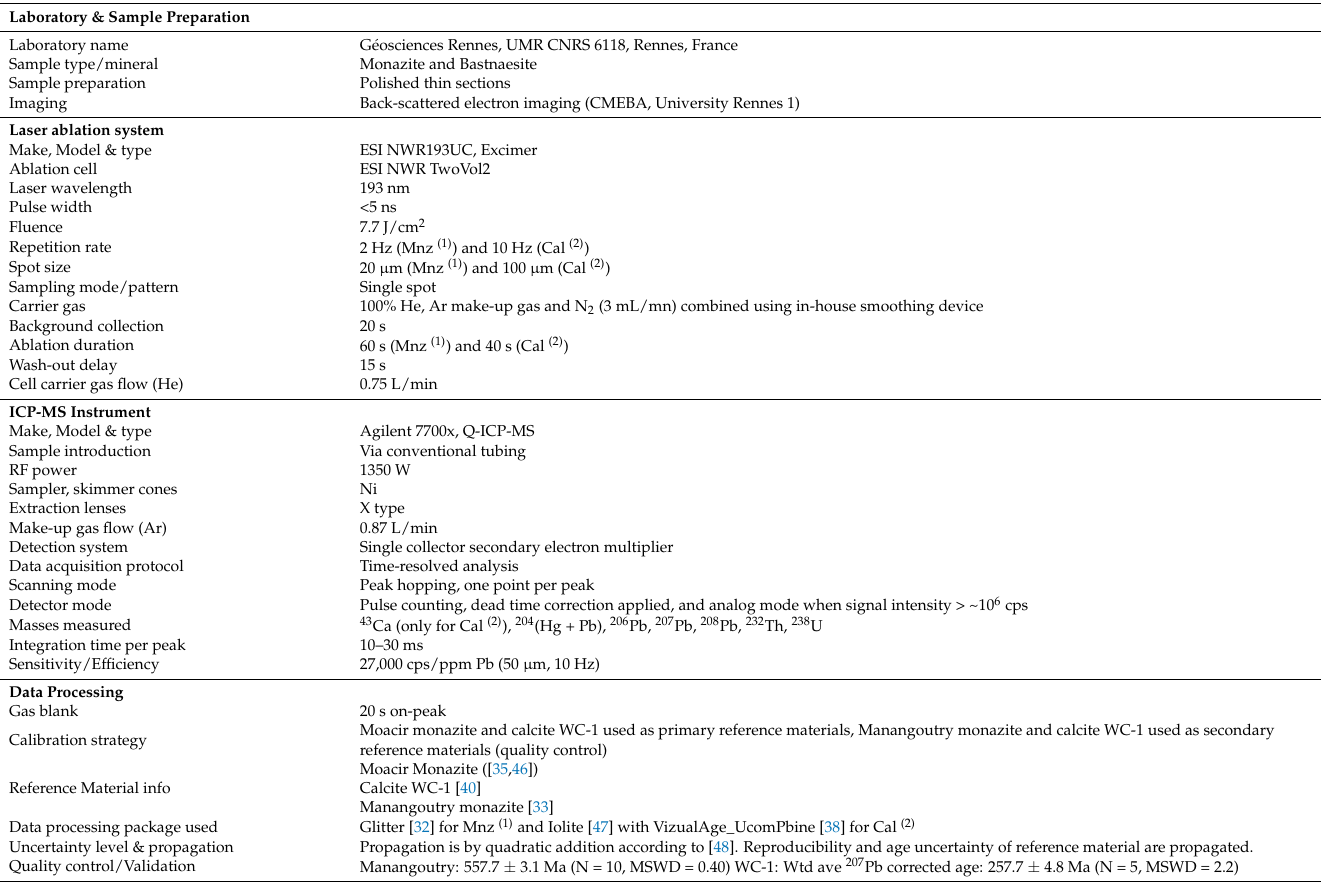
Table A1. Operating conditions for the LA-ICP-MS